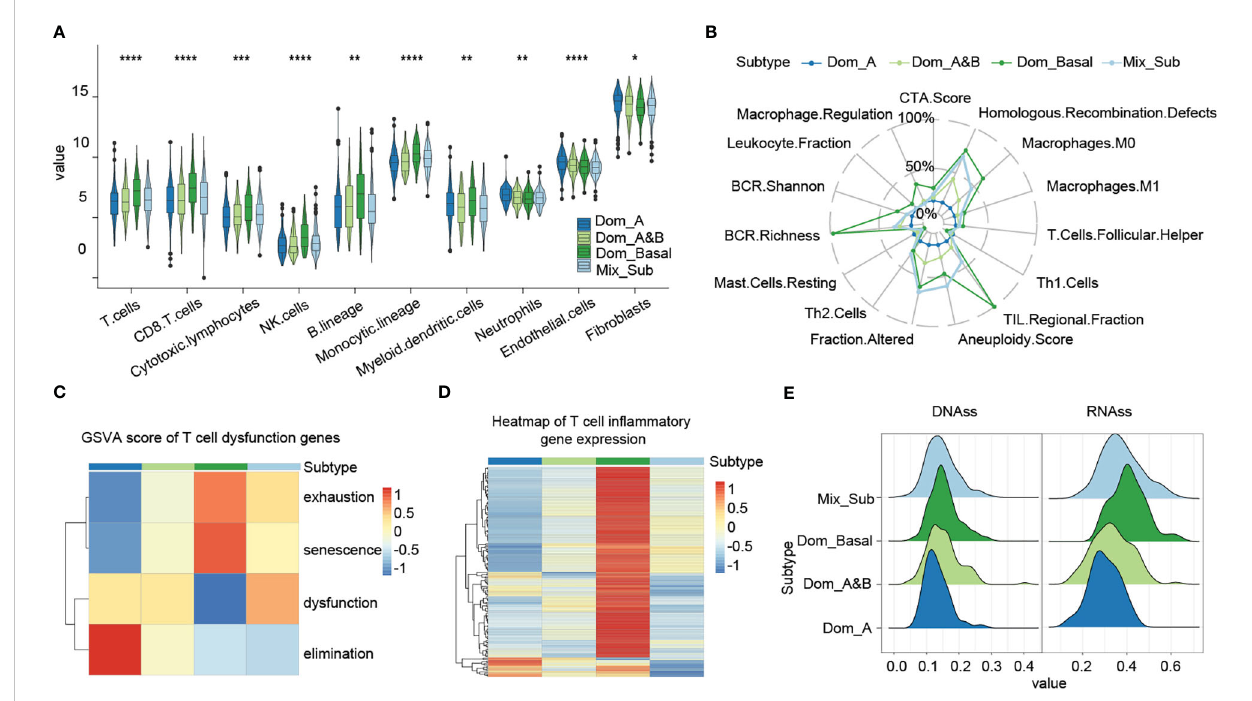
FIGURE 4 (A) Immune in fi ltration level score based on the MCP-counter method (Kruskal-Wallis test, ‘ * ’ p < 0.05, ‘ ** ’ p < 0.005, ‘ *** ’ p < 0.0005, ‘ **** ’ p < 0.00005).. (B) Immune signature scores, based on the Dom_A subtype, and relative scores of other subtypes. (C) GSVA enrichment scores for genes associated with T-cell disorders. (D) Expression of T-cell in fl ammatory genes. (E) Cancer stemness cell